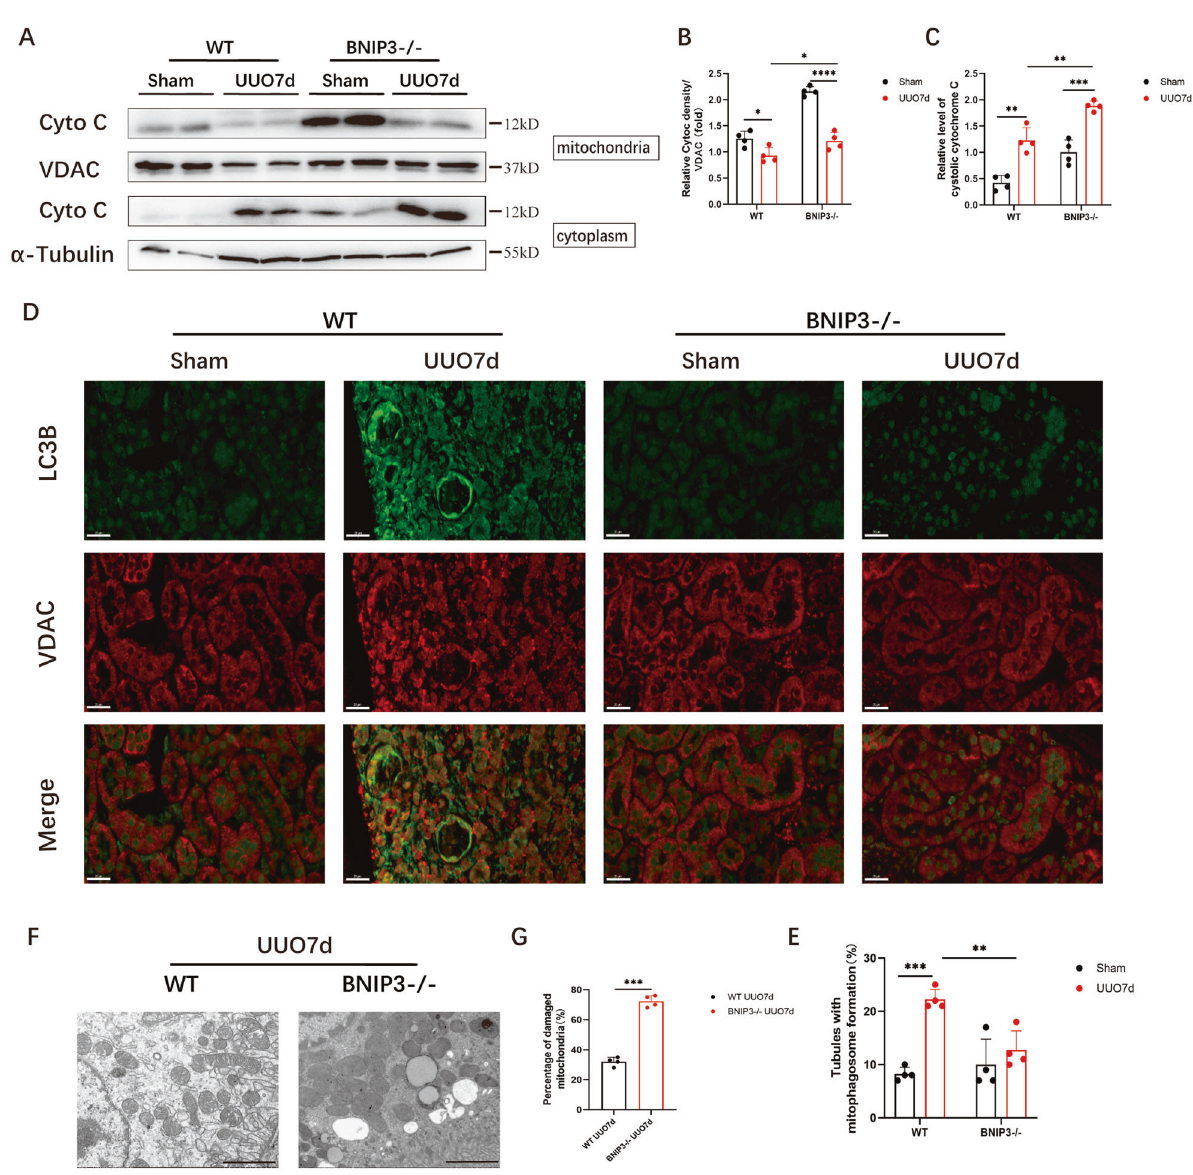
Fig. 3 BNIP3 de fi ciency enhanced mitochondrial damage and the release of cytochrome C following UUO. A – C Immunoblot analysis and quanti fi cation of cytochrome C in cytosolic and mitochondrial fraction ( n = 4 per group). D , E Representative images of immuno fl uorescence double-labelling LC3B and mitochondrial outer membrane protein (VDAC) in sham-operated kidneys or obstructed kidneys in WT and BNIP3-/- mice ( n = 4 per group). Scale bar, 20 μ m. F Representative images of proximal tubular epithelial cells by transmission electron microscopy and G quanti fi cation data of damaged mitochondria in different groups of mice: WT and BNIP3 knockout ( n = 4 per group). Scale bar, 2 μ m (×7000). Error bars: SEM. * p < 0.05; ** p < 0.01; *** p < 0.001; **** p < 0.0001. mitophagy pathway. In addition, we used immunoblot analysis to the siBNIP3 + hypoxia group were more signi fi cantly reduced than examine NLRP3 in fl ammasome activation. The results showed that those in the siNC + hypoxia group in HK-2 cells. BNIP3 de fi ciency NLRP3, cleaved caspase-1, and mature IL-1 β were increased markedly reduced the activity of the SOD enzyme in mitochondria signi fi cantly in the hypoxia-treated group after BNIP3 silencing (Fig. under hypoxic conditions following inhibition of the BNIP3-mediated Cell Death and Disease (2023)